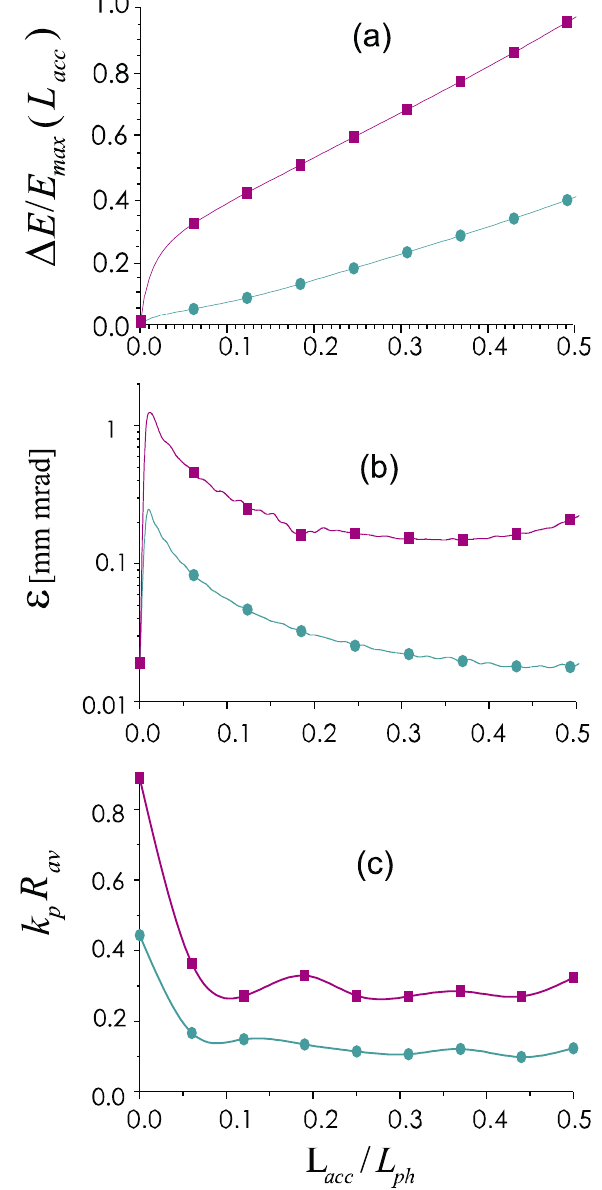
FIG. 3. (Color) Quality of an accelerated electron bunch in channel guided LWFA; a (cid:1) 0.71 , k p r L (cid:1) 3.8 , k p R ch (cid:1) 14.3 , E inj (cid:1) 100 mc 2 , L ph (cid:1) 512 cm; (a) energy spread; (b) geomet- ric emittance; (c) average e -beam radius; circles: L b (cid:1) r b (cid:1) 0.1 l p ; boxes: L b (cid:1) r b (cid:1) 0.2 l p